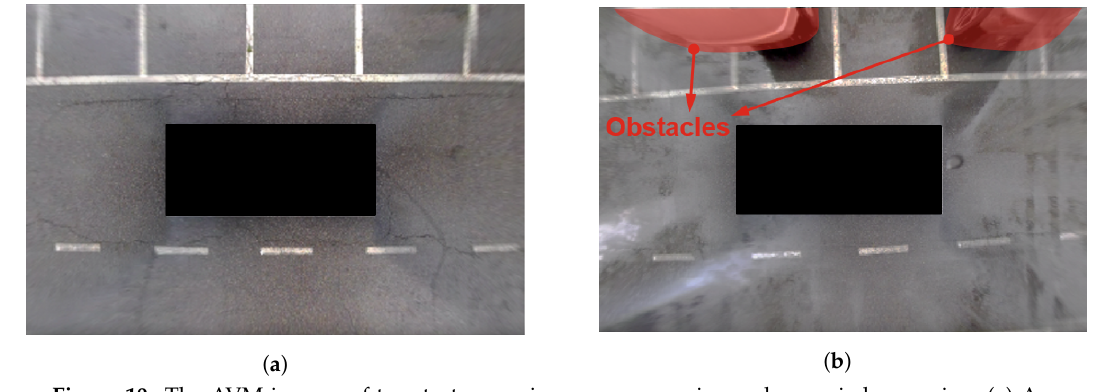
Figure 10. The AVM images of two test scenarios: open scenarios and occupied scenarios. ( a ) An open scenario; there is no other obstacles around the vehicle, ( b ) An occupied scenario; there are other obstacles around the vehicle.